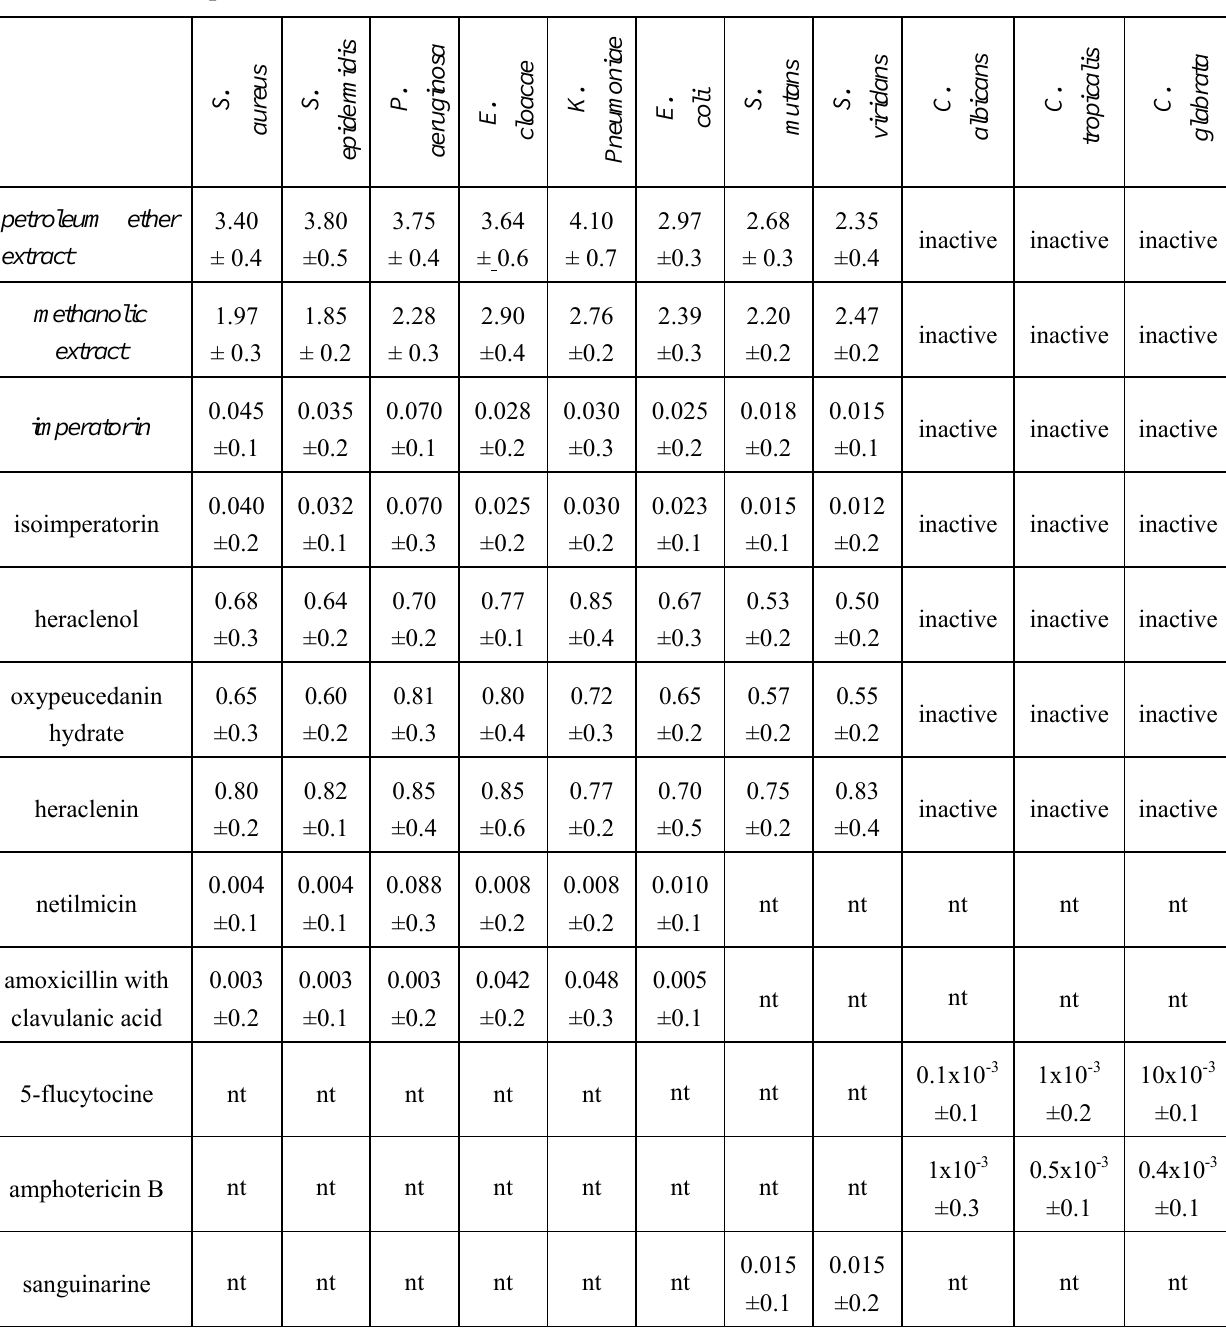
Table 1. Antimicrobial activities MIC values (mg/mL, n=3) of the assayed extracts and isolated compounds.